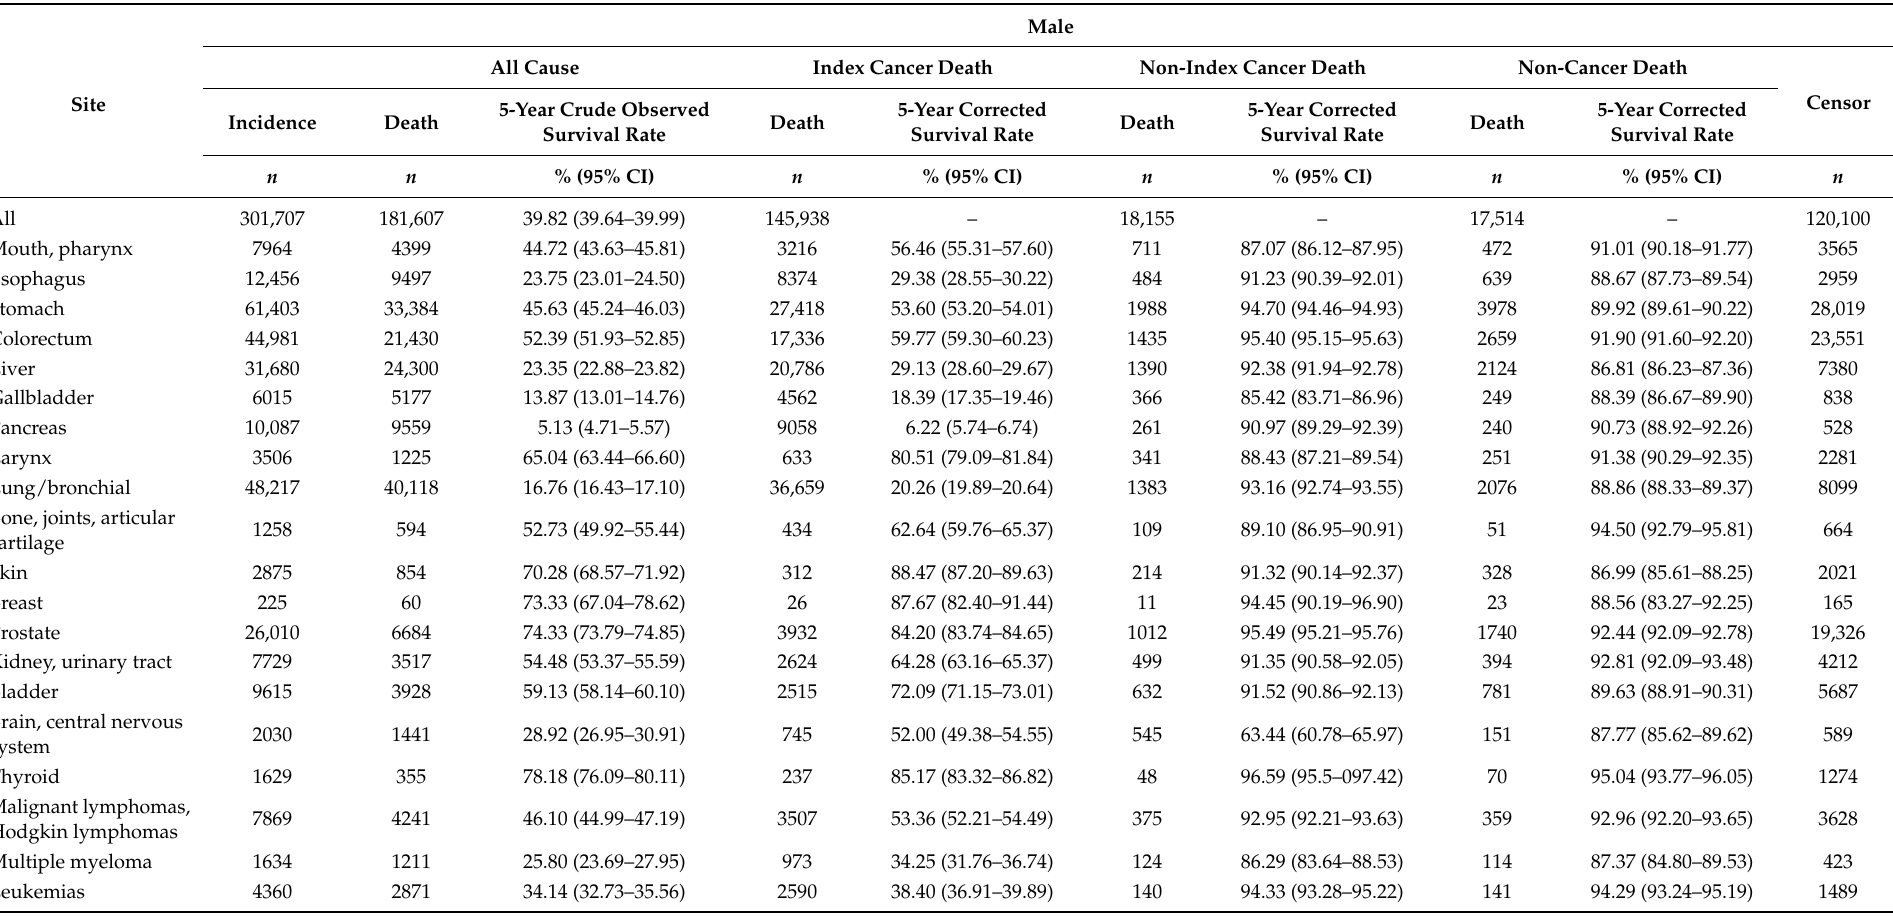
Table 4. Summary of cancer morbidity and 5-year cancer mortality by cause of death (male, incidence: 1995–2011, death or survival: